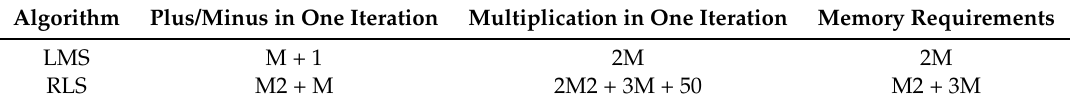
Table 1. Computational cost of the least mean squares (LMS) and recursive least mean squares (RLS) algorithms.